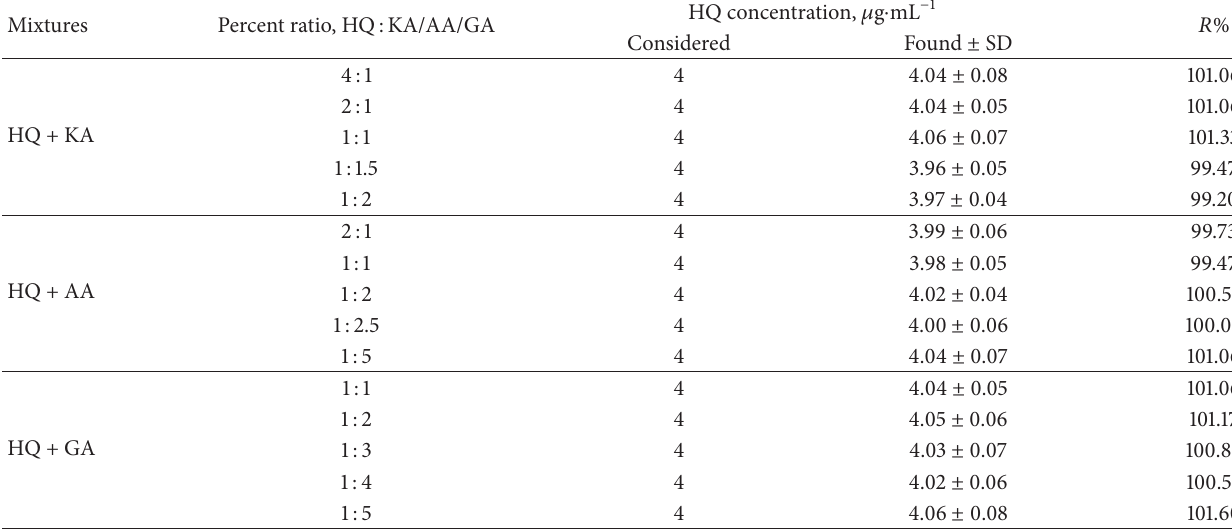
Table 4: Results of the HQ determination in synthetic binary mixtures by applying the proposed spectrometric method; 𝑛 = 3 .